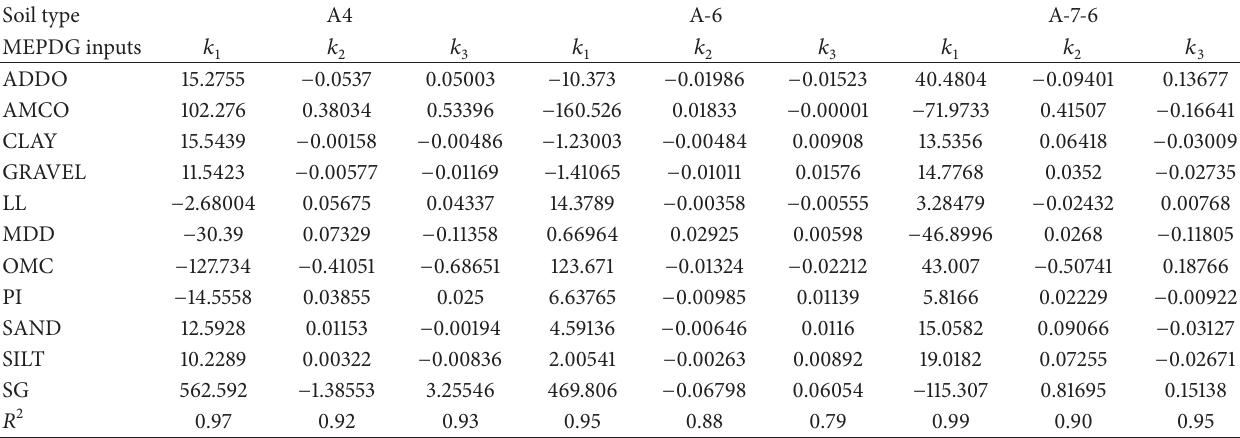
Table 8: Correlation between MEPDG inputs and soil properties at